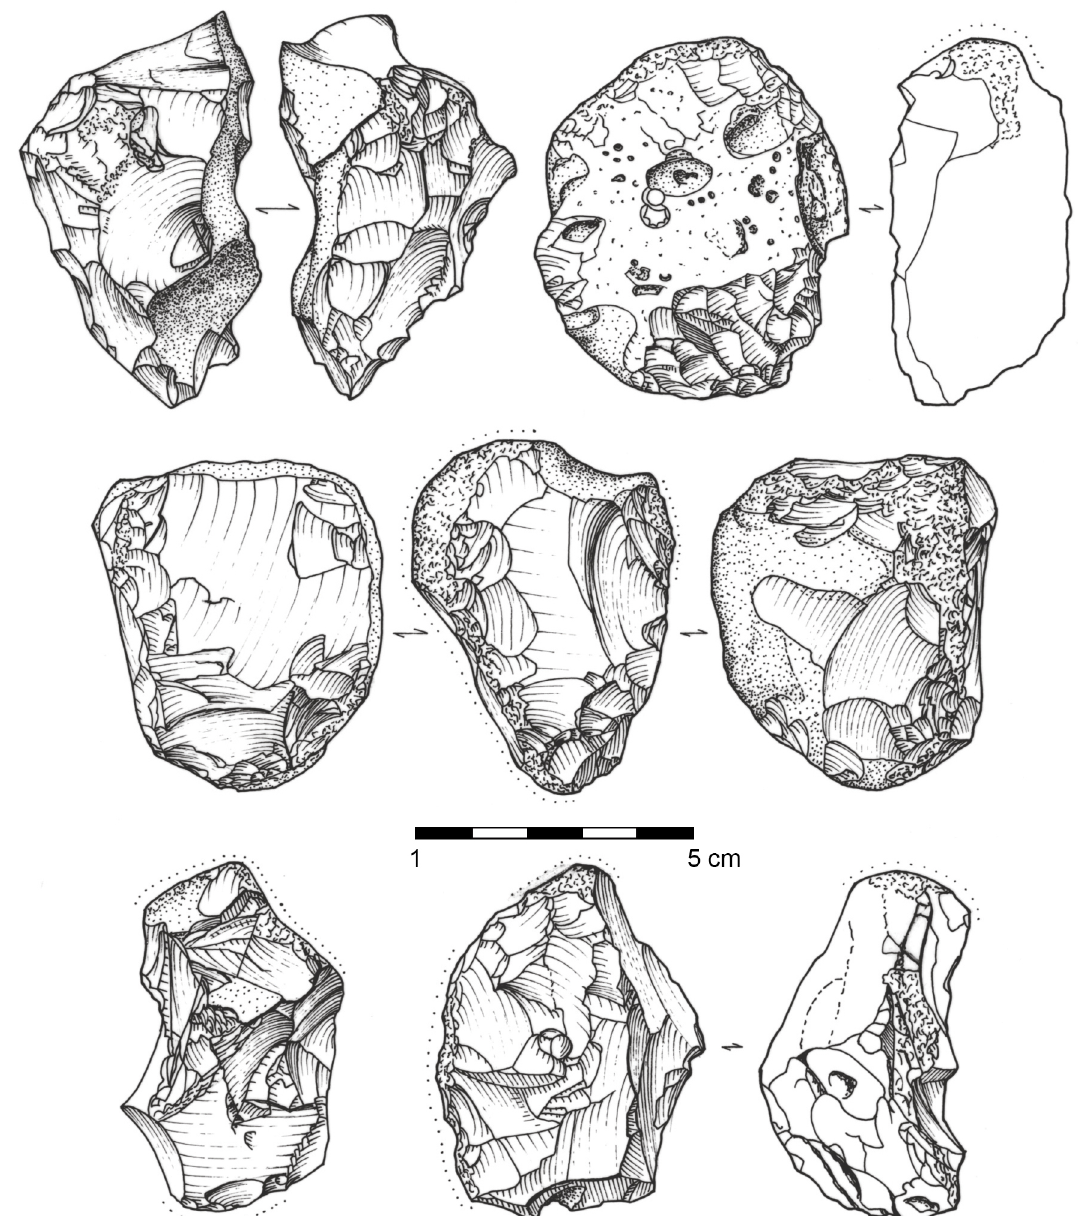
Figure 9. Percuteur en silex du site de Saint-Pierre-d’Autils «Le Plaquis», (Eure). Dessin de D. Prost. Figure 9. Hammerstone made of flint from Saint-Pierre-d’Autils site “Le Plaquis”, (Eure). Drawing by D.